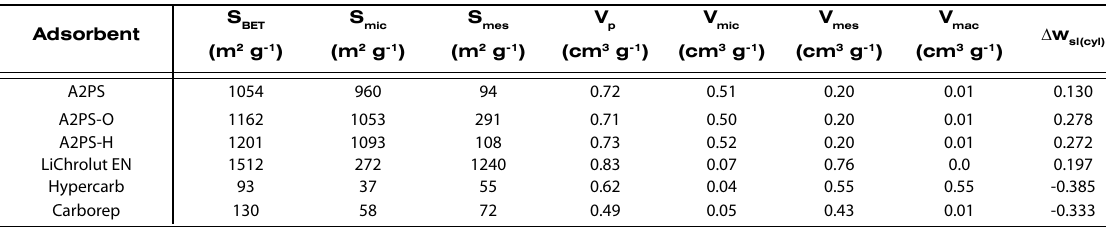
Table 2. The S and V values and structural characteristics of adsorbents calculated using the DFT method with the model of slit-shaped BET p (carbons) or cylindrical (LiChrolut EN) pores Adsorbent